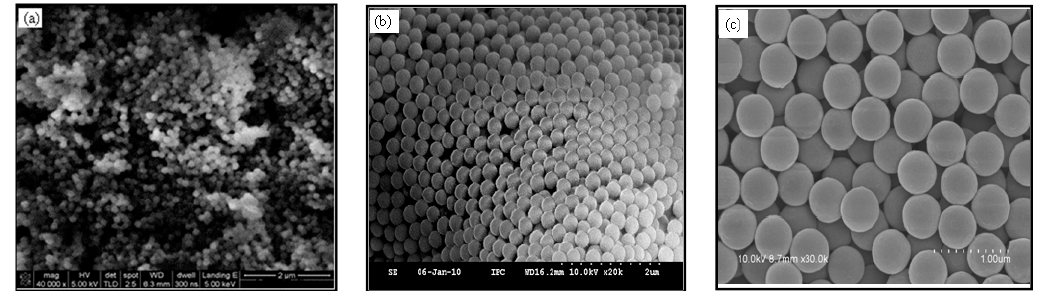
Figure 1. SEM image of PS particles dispersed in pure water after drying for particle sizes of ( a ) 141 nm, ( b ) 311 nm, and ( c ) 535 nm.